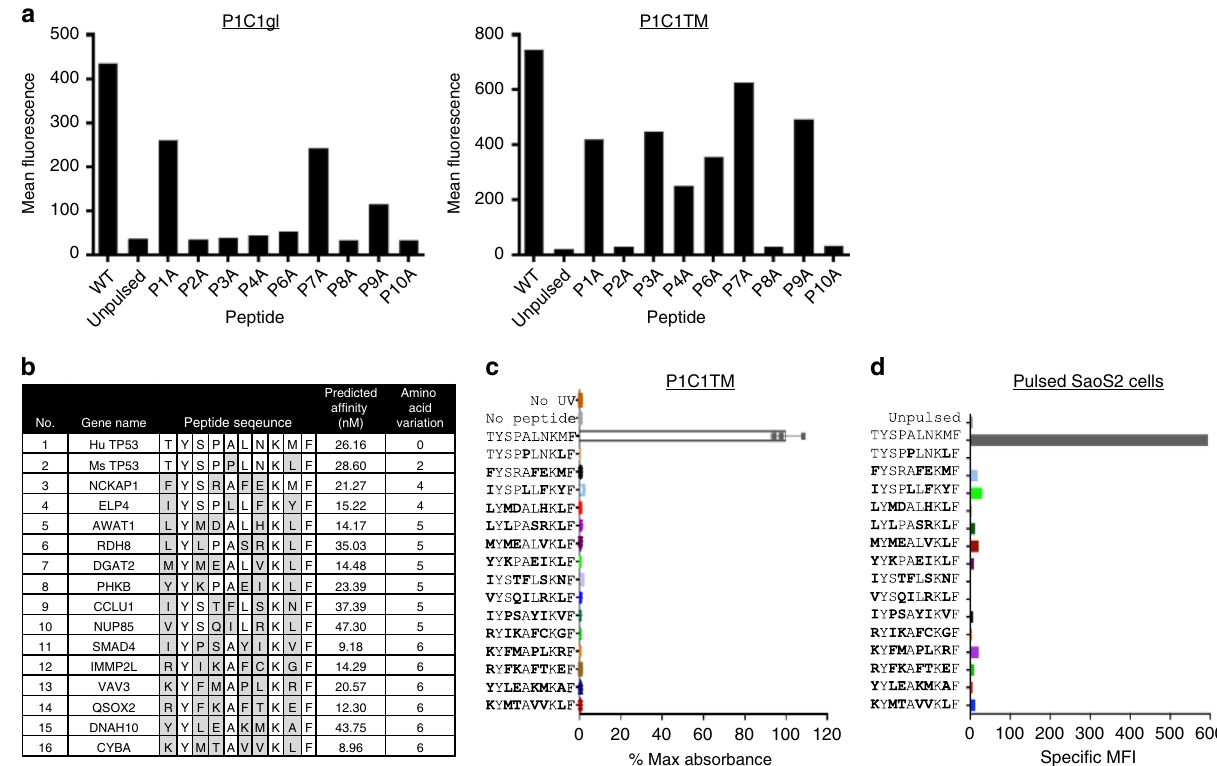
Fig. 3 Fine speci fi city of af fi nity matured TCRL antibody P1C1TM. a SaoS2 cells pulsed with p53 125 – 134 peptide analogues containing single amino acid mutations to alanine were stained with 10 µ g mL − 1 of P1C1gl (left) or the af fi nity-matured P1C1TM (right) and detected with an Alexa Fluor 647-conjugated anti-human IgG secondary antibody. Data are representative of two independent experiments. b Potential off-target peptides were identi fi ed using the MOTIF search tool and analysed by NetMHC 3.0 for predicted binding af fi nity to HLA-A*24:02. Peptides with predicted binding af fi nity of 100 nM or less were used to determine the cross-reactivity of P1C1TM. The murine p53 118 – 127 that differs from the human p53 125 – 134 by only two amino acids at positions 5 and 9 was also included. c Soluble pMHCs presenting the panel peptides was produced by UV exchange and used to assess P1C1TM ’ s fi ne speci fi city by ELISA. No UV exchange pMHC and no peptide exchange controls were used as negative controls, while pMHC UV-exchanged with p53 125 – 134 peptide was used as a positive control. Data are means of triplicates ± SEM. d The panel of peptides were pulsed on SaoS2 cells and stained with 10 µ g mL − 1 P1C1TM. Unpulsed SaoS2 cells were used as negative control, while SaoS2 cells pulsed with p53 125 – 134 peptide was used as a positive control. Data are representative of two independent